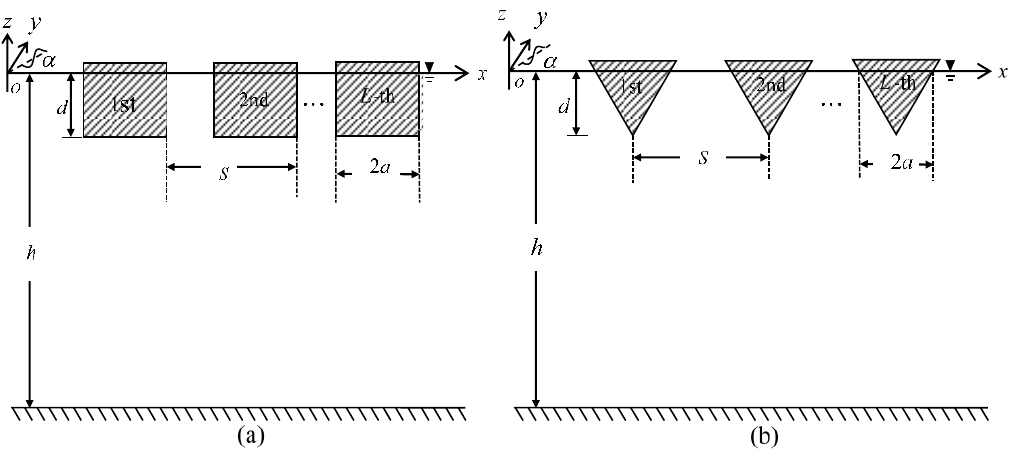
Figure 8. Schematic diagram of Bragg reflections by periodic ( a ) rectangular and ( b ) triangular surface-piercing structures over flat bottom.